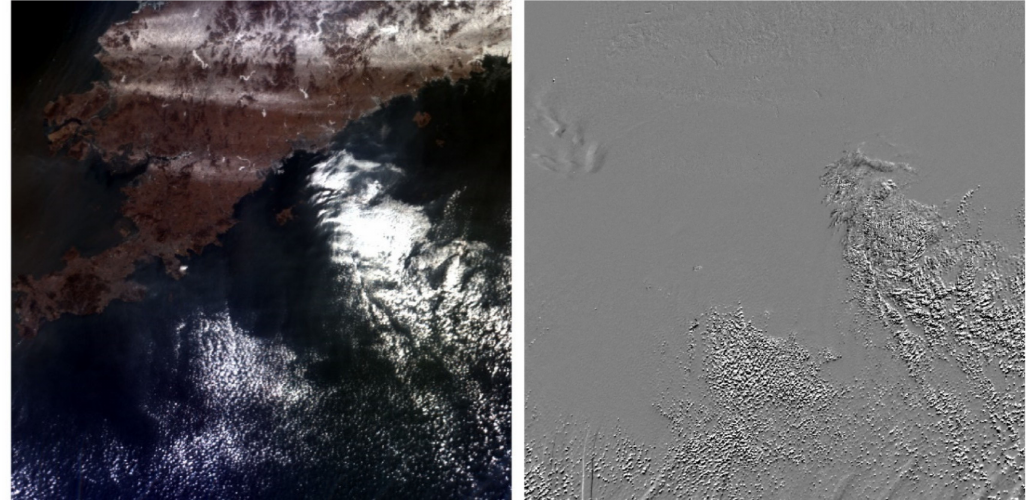
Figure 6. False-color GF-4 image of the Liaoning area using the NIR-R-G composition (left) and a di ff erence map of two time-adjacent blue band images of the same area